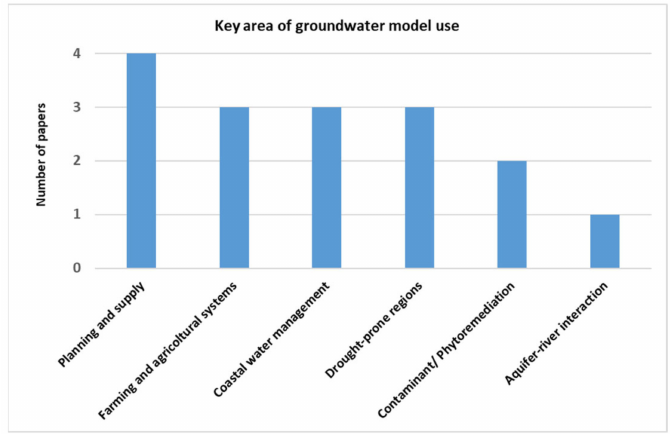
Figure 3. Key areas of groundwater models use in the reviewed